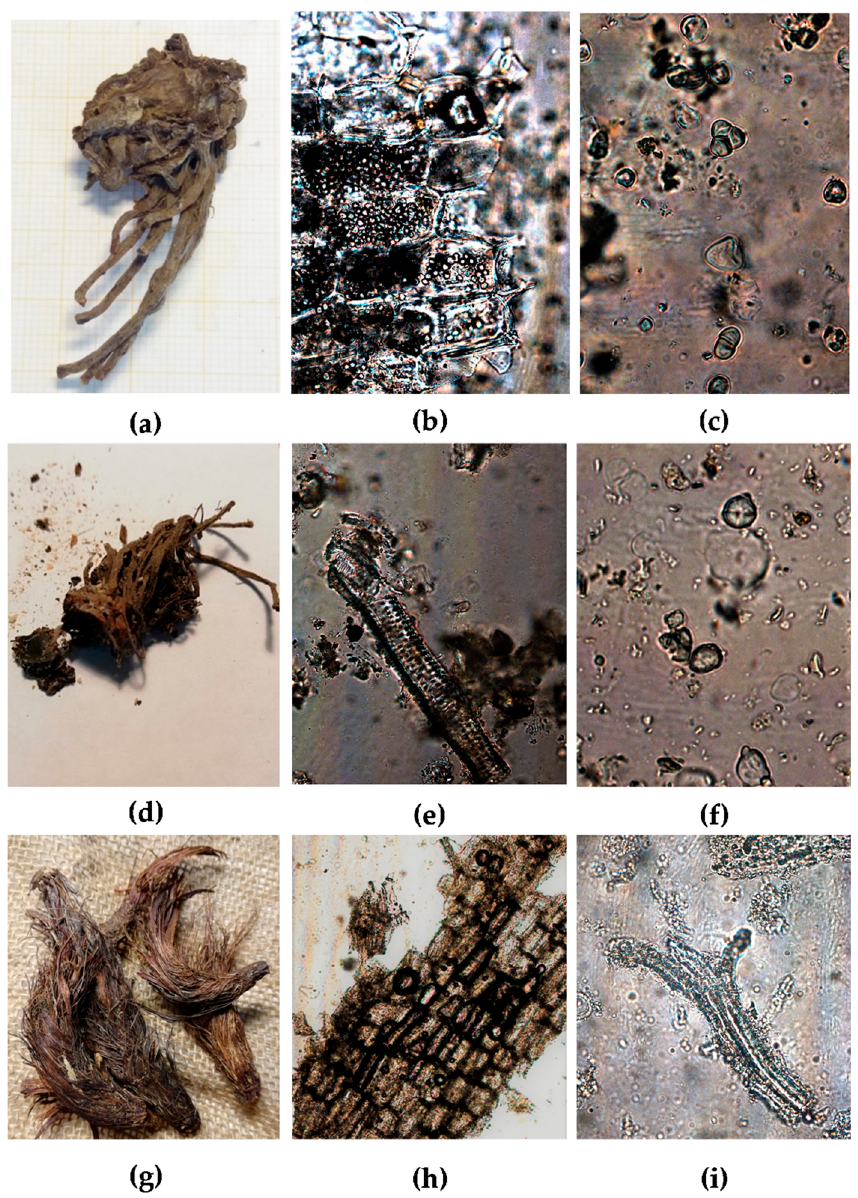
Figure 1. ( a – c ) Vo: ( a ) dried root/rhizome; ( b – c ) powdered material: ( b ) parenchymatous cells with starch grains (20×); ( c ) starch grains (40×); ( d – f ) Vj: ( d ) dried root/rhizome; ( e – f ) powdered material: ( e ) scalariform vessels (20×); ( f ) starch grains (40×); ( g – i ) Nj: ( g ) dried root/rhizome; ( h – i ) powdered material: ( h ) cork cells (10×); ( i ) fibers and small starch grains (40×).